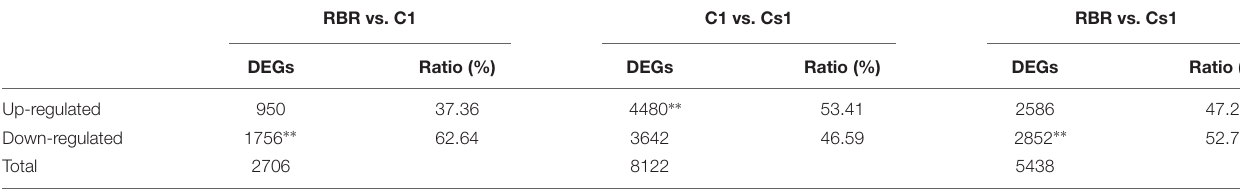
TABLE 3 | Summary of trans -effected DEGs in three